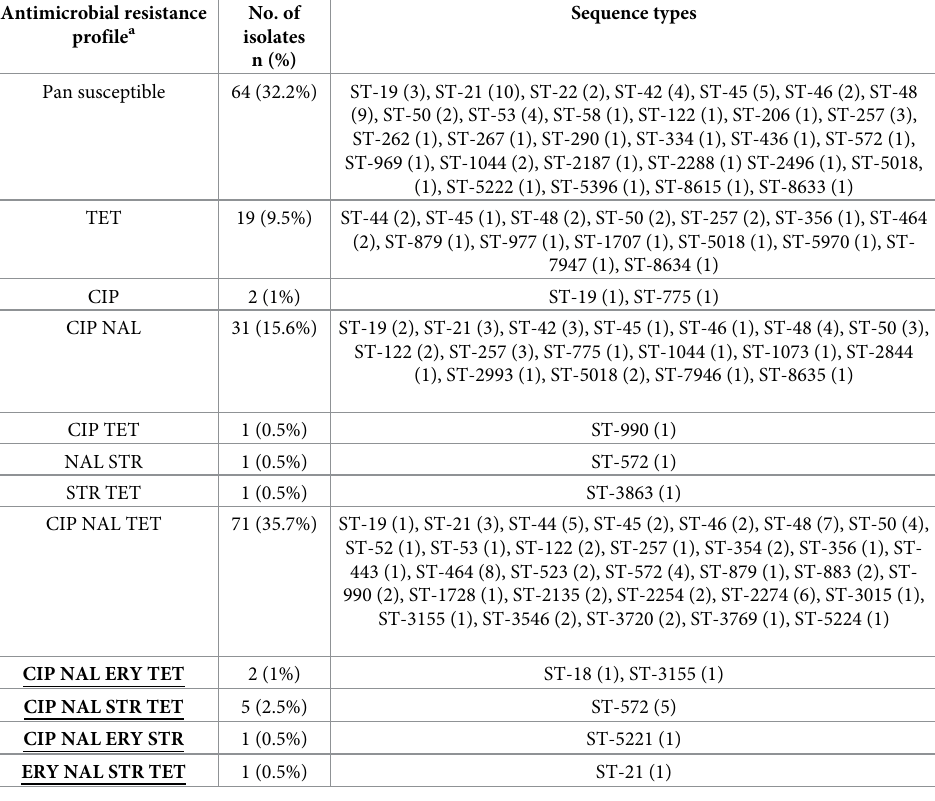
Table 2. Antimicrobial resistance patterns and MLST sequence types among clinical C . jejuni